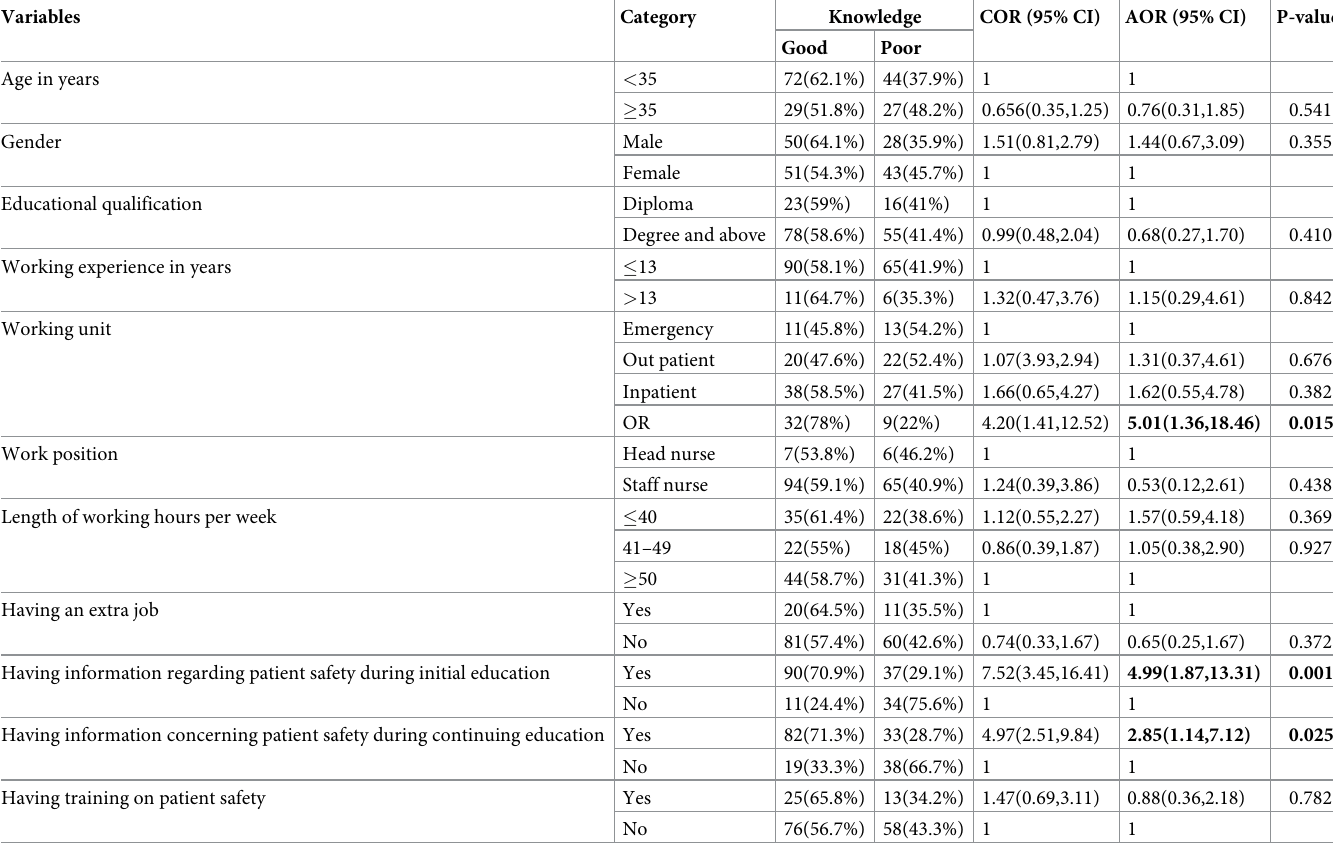
Table 3. Bivariable and multivariable logistic regression analysis of factors associated with knowledge towards patient safety among nurses working at Asella Refer- ral and Teaching Hospital, Asella, Ethiopia, 2021, [n =